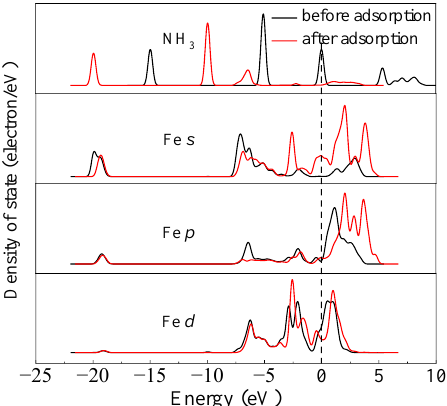
Figure 2. The PDOS for the system before and after NH 3 adsorption onto the γ -Fe 2 O 3 (111)